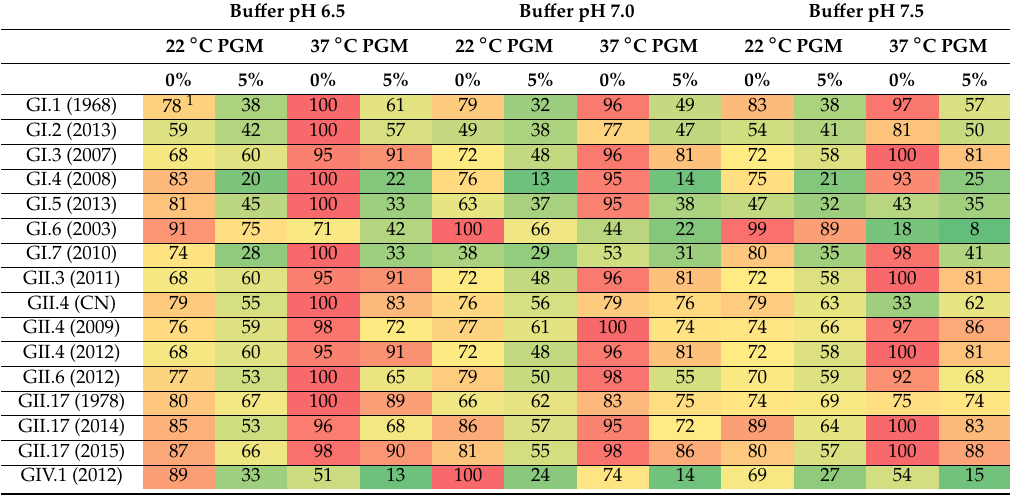
Table 1. Pig gastric mucin (PGM) binding by virus-like particles (VLPs) under di ff erent conditions